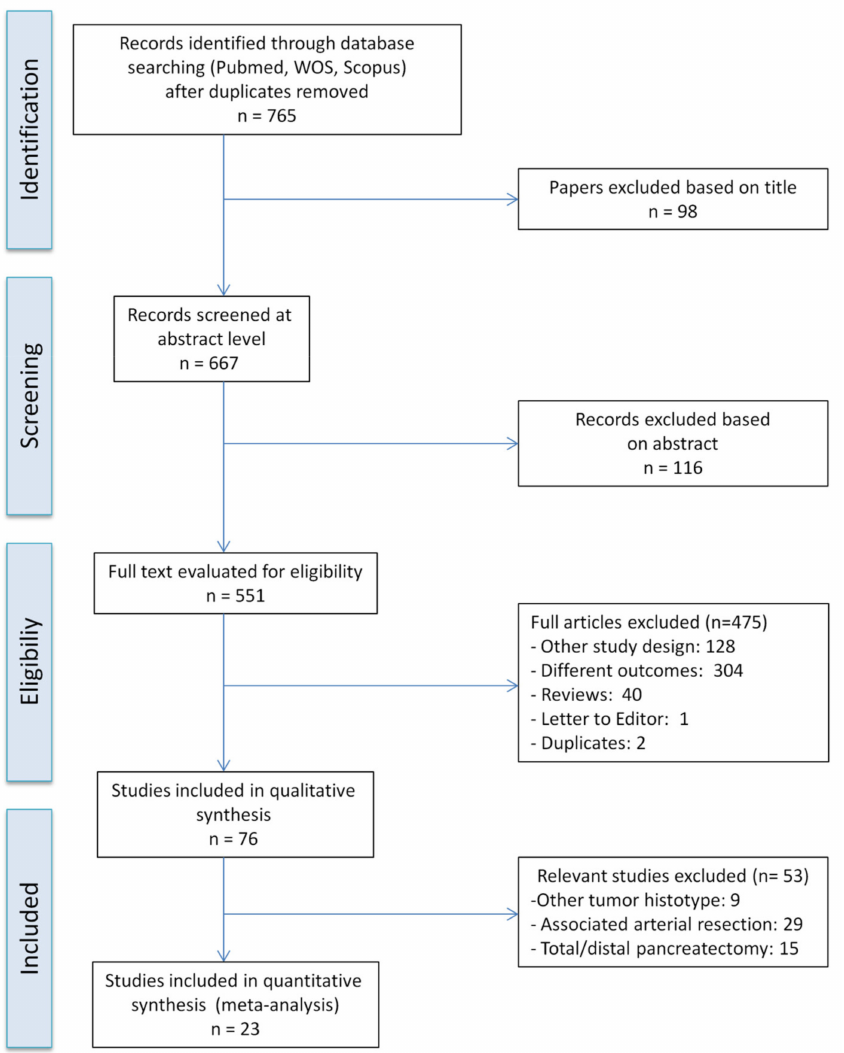
Figure 1. Flowchart of study selection for the